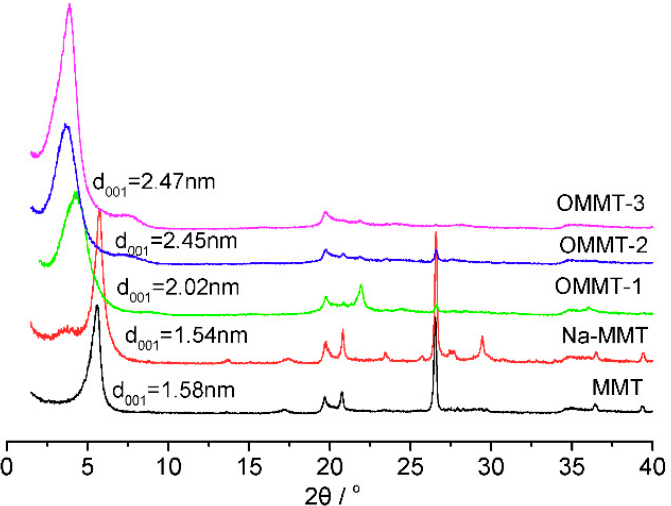
Figure 7. XRD pa tt erns of the montmorillonite (MMT), Na-MMT, OMMT-1, OMMT-2, and OMMT-3 samples.